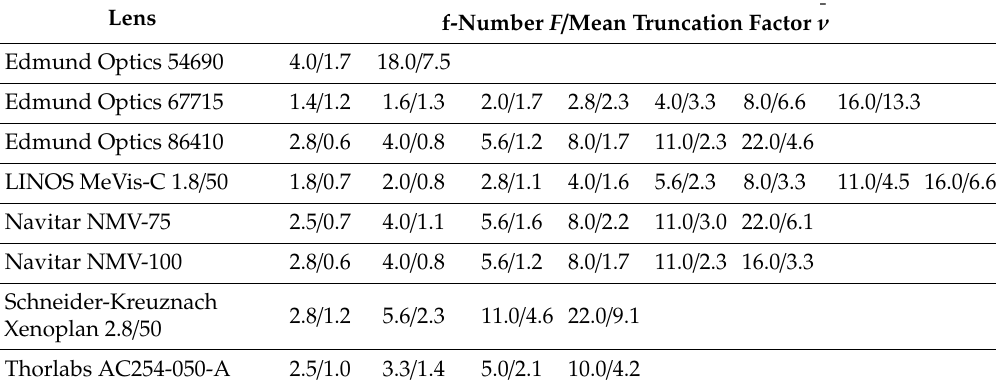
Table 6. f-number settings used for the measurement series and their corresponding mean truncation factor.